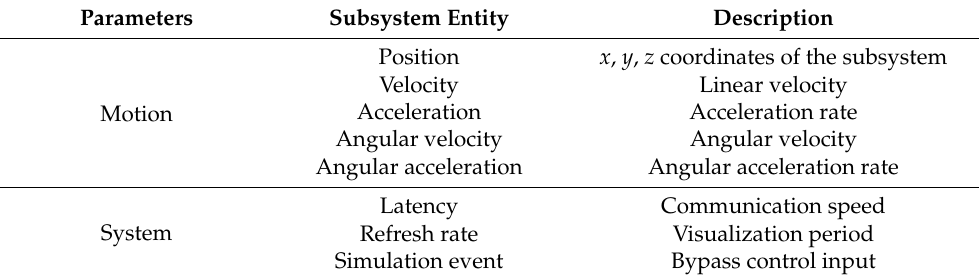
Figure 4. Components and data flow of the machine emulator. Table 2. Parameters used in the machine emulator. Table 2. Parameters used in the machine emulator.